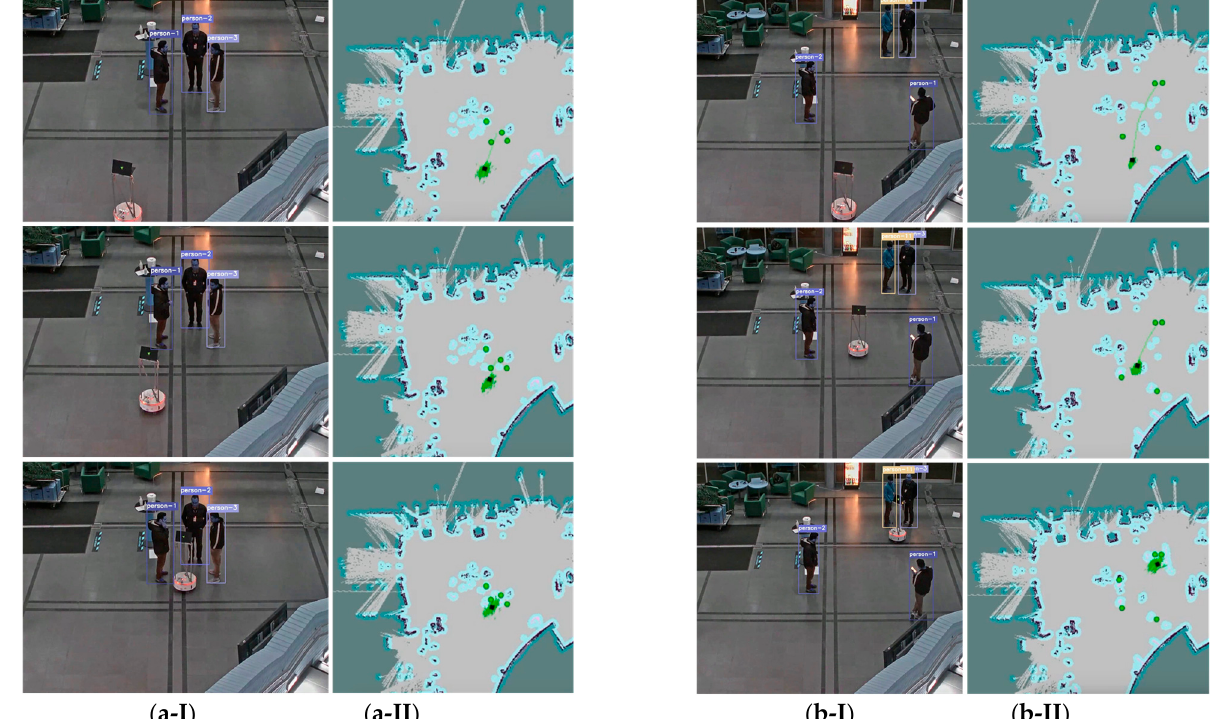
Figure 8. Localization of non-compliant groups and navigation of robot to give the alert message. ( a-I , a-II ) represent the experiment based on three persons, and ( b-I , b-II ) represent the experiment based on two persons in a non-compliant group. ( a-II , b-II ) show the navigation and localization of the robot and the persons belonging to non-compliant group on the map. Green and black markers on map represent the persons and the robot, respectively.